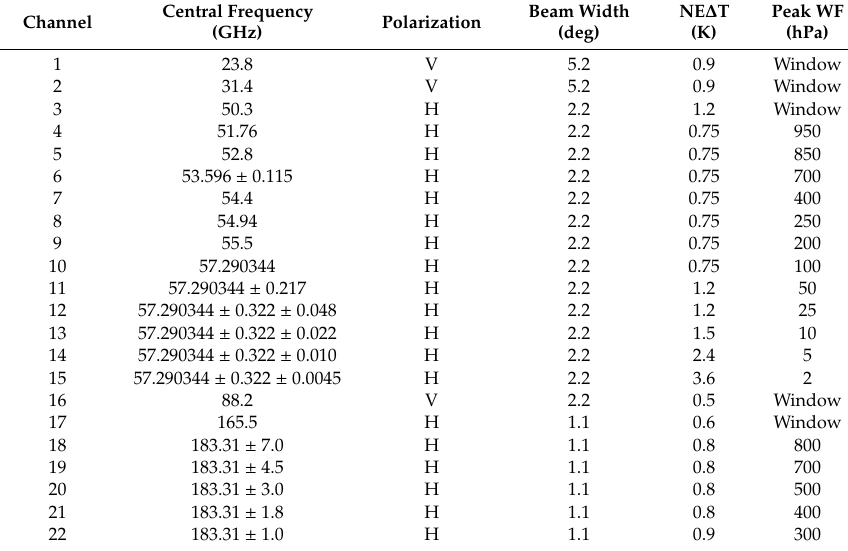
Table 1. Channel Characteristics of